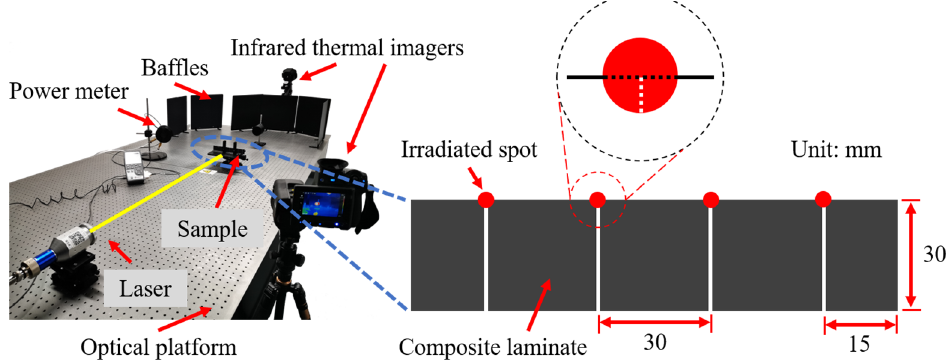
Figure 2. Laser irradiation test platform.